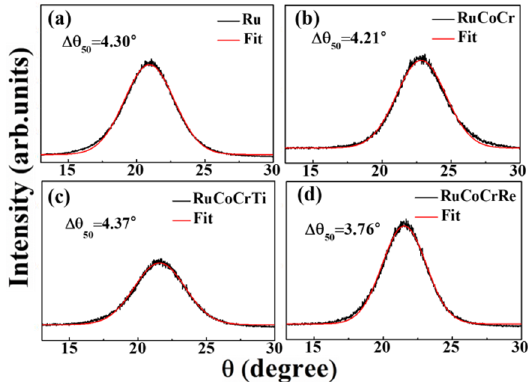
Figure 2. Rocking curves of (a) Ru, (b) RuCoCr, (c) RuCoCrTi, and (d) RuCoCrRe (0002) peaks.